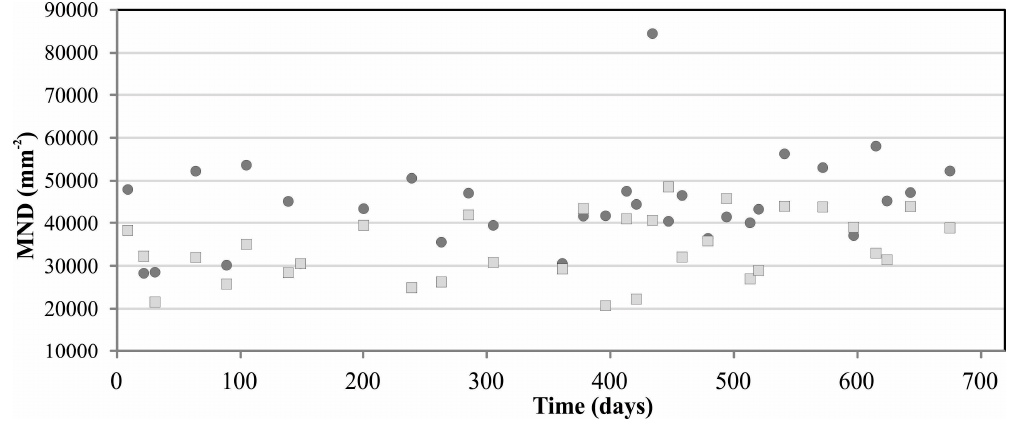
Figure 6. Microlite number density of BVVR (solid rectangle) and BVR (solid circle) over the time in 2011–2012 eruptions.